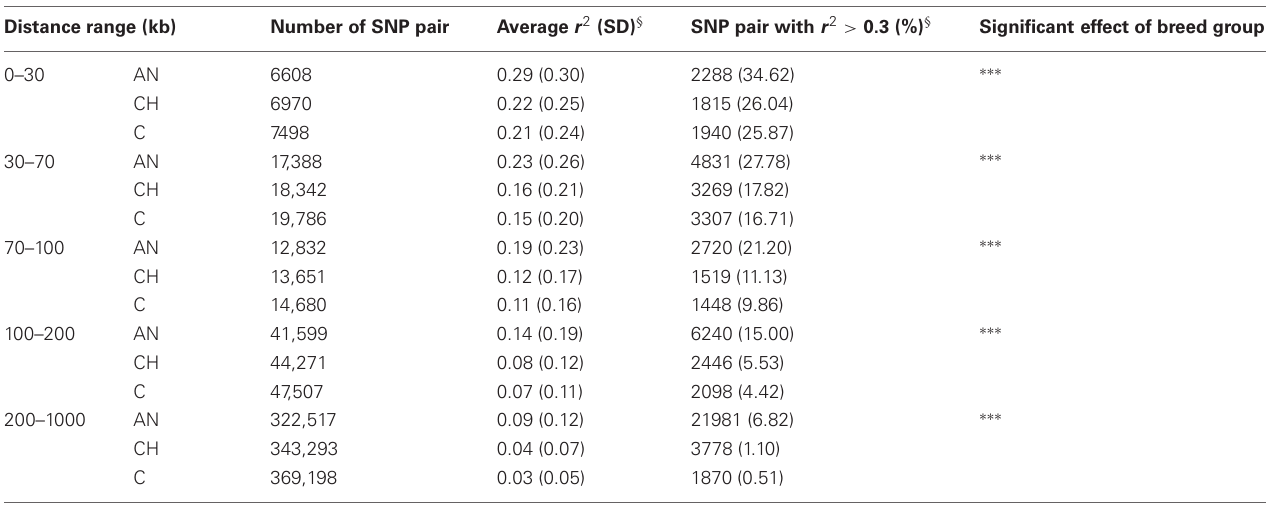
Table 3 | LD over varied